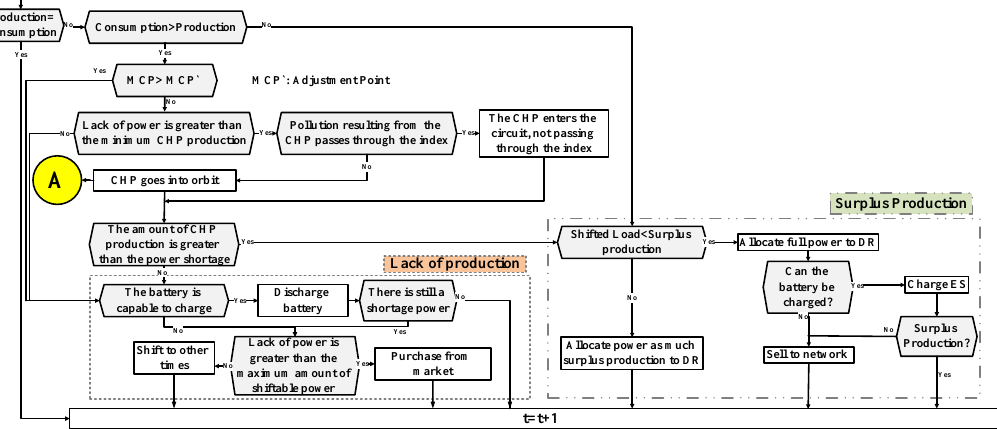
Figure 5. Flowchart of EMS-DRPE (Electrical